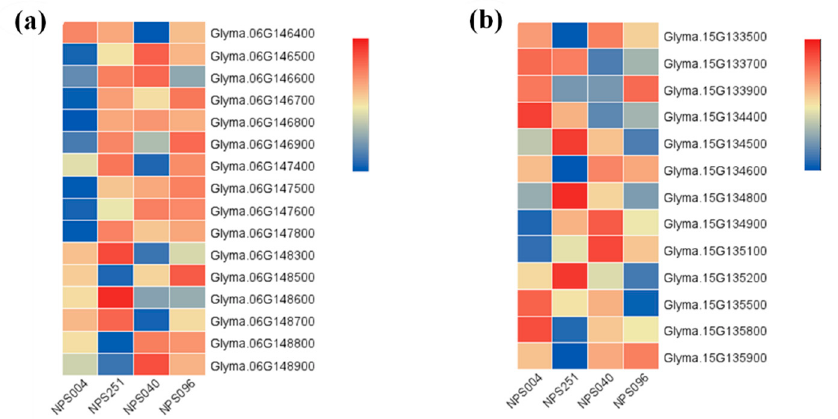
Figure 5. Heatmap profiles of expressed candidate genes in soybean accessions. ( a ) Heatmap profiles of candidate genes on Chr.06; ( b ) heatmap profiles of candidate genes on Chr.15. Red is higher expression and blue lower, columns refer to accessions and rows to genes.